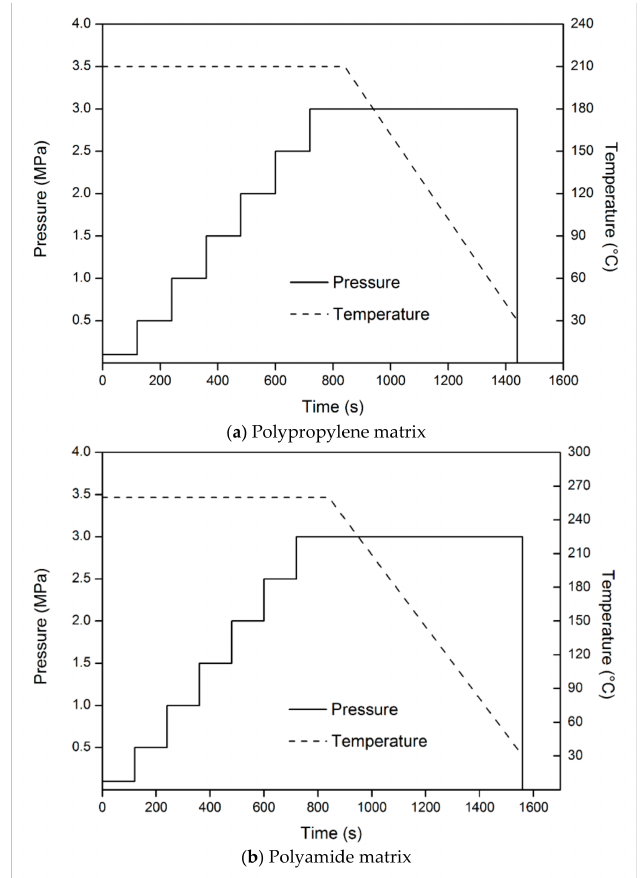
Figure 1. Molding compression pressure and temperature against time for polypropylene (PP) based ( a ) and polyamide (PA6B) based ( b )